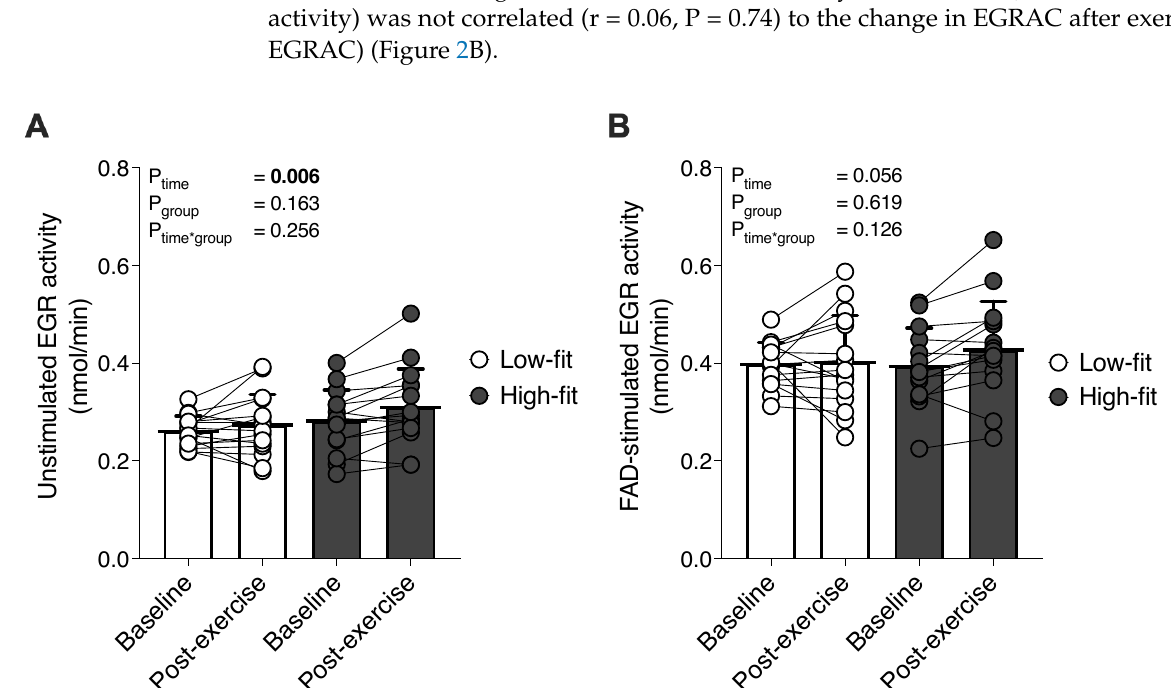
Figure 1. The effect of a single exercise bout on unstimulated and FAD-stimulated EGR activity in high-fit and low-fit females. Baseline and post-exercise unstimulated EGR activity (expressed as nmol NADPH converted per minute ( A )), and FAD-stimulated EGR activity (expressed as nmol NADPH converted per minute ( B )), in low-fit (N = 16, white) and high-fit (N = 15, grey) females.